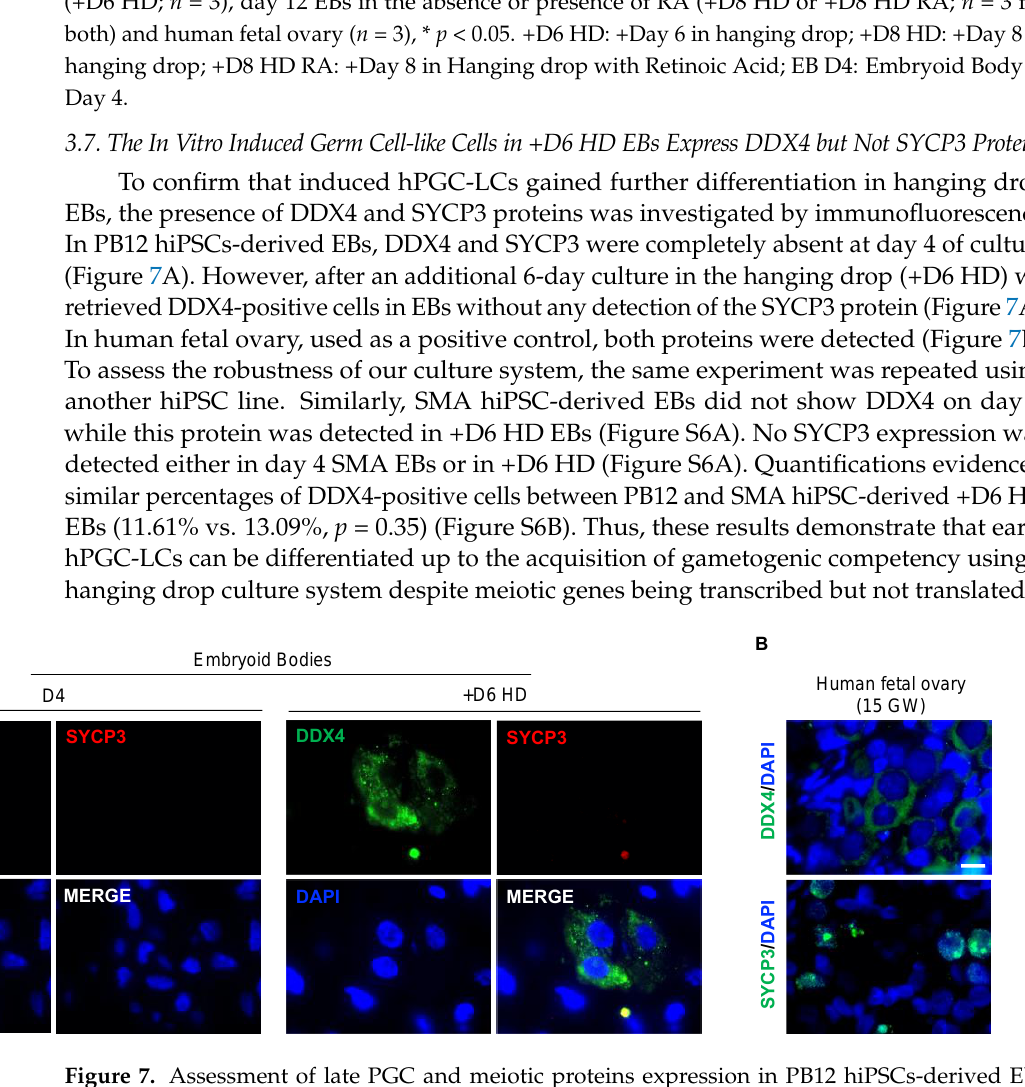
bodies in the hanging drop culture system. At day 10, embryoid bodies are exposed or not to RA for 48 h. ( B ) Images of (i) a day 4 EB in a U-bottom low adherence 96-well plate, (ii) a day 10 EB, and